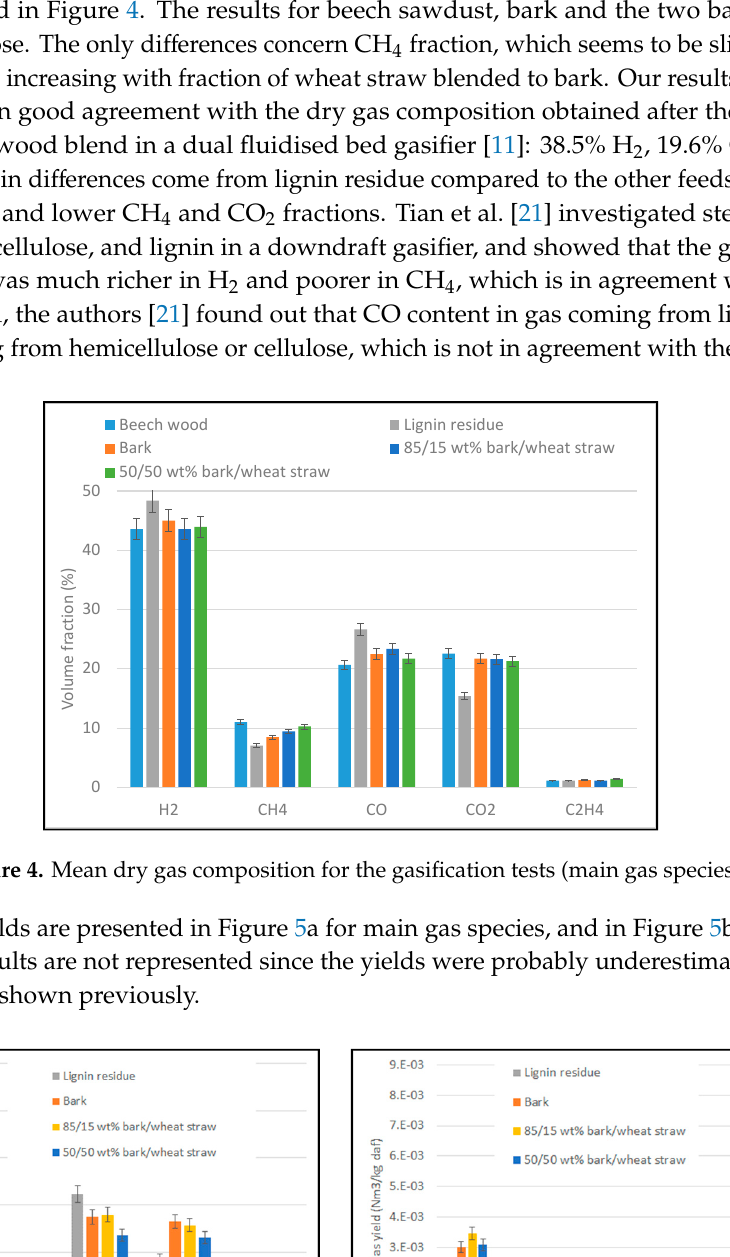
Figure 5. Mean gas species yields for the gasification tests, ( a ) major species, ( b ) minor species.